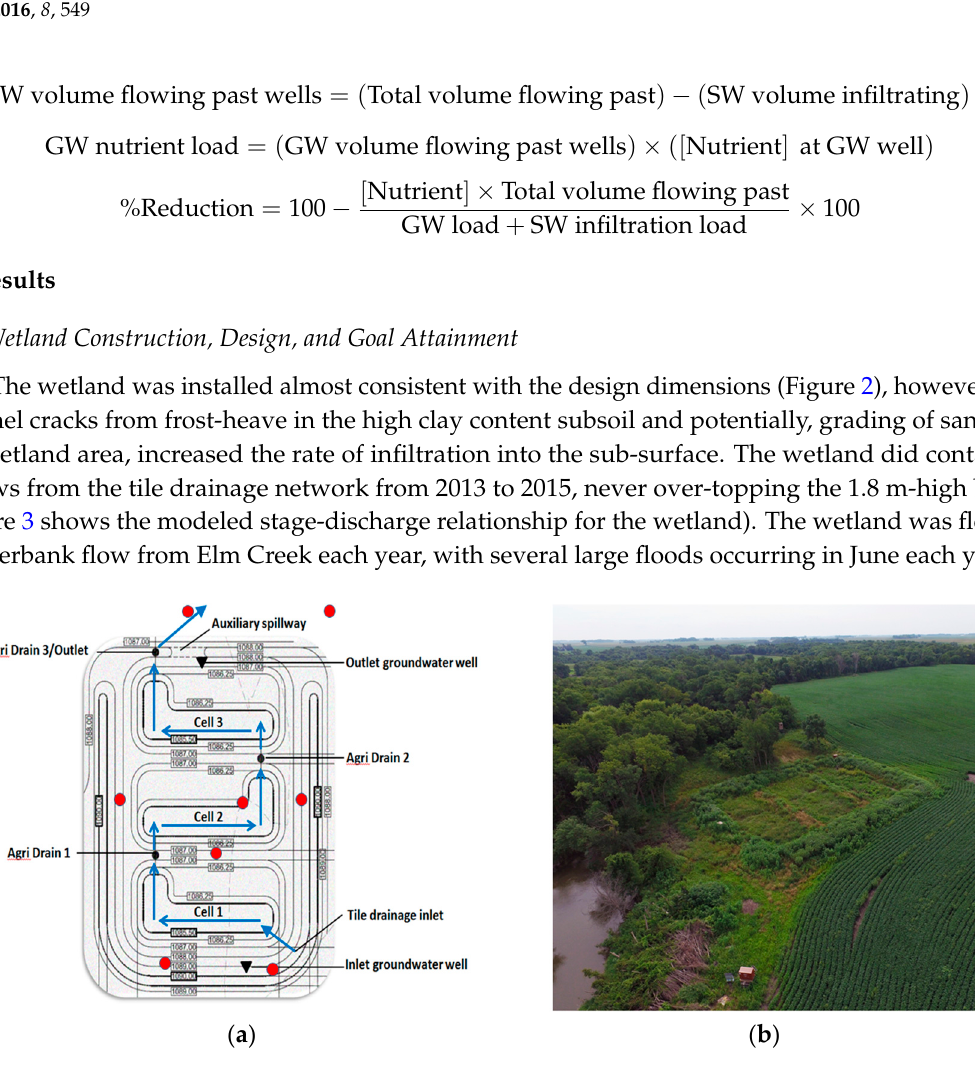
Figure 2. ( a ) Schematic of treatment wetland design; ( b ) Right: aerial view of treatment wetlands in July 2016. Subsurface tile flow from farmland located uphill drains into the wetland system and meanders through the three cells prior to discharging in the upper left corner to Elm Creek, shown in lower left of the right image. Photo by David Hansen.